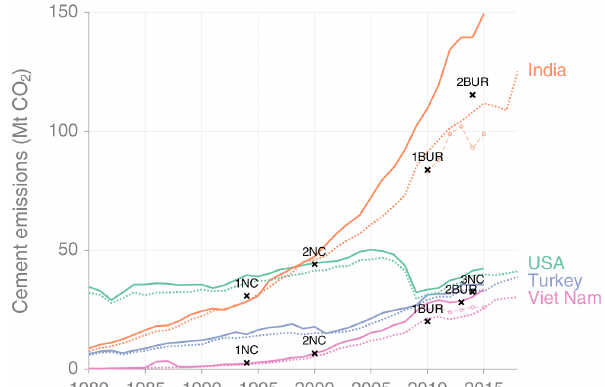
Figure 2. Global process emissions from cement production, with 95% confidence interval. A step change in relative uncertainty oc- curs in 1990, reflecting a significant change in data availability.